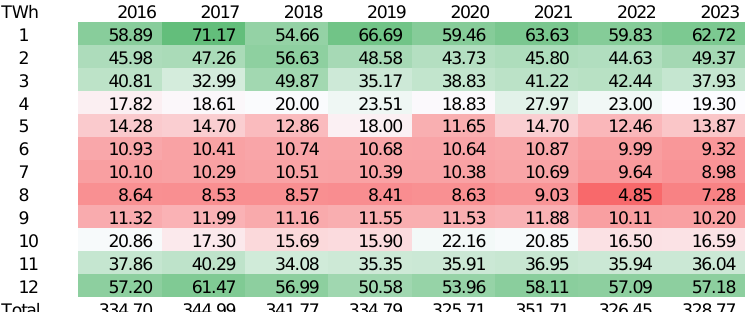
Figure 9. Neutral forecast of LNG for 2024. Forecast exercised for the period September 2022 to December 2023. These data can be found here: https://www. ec.europa.eu/ (accessed on 20 March 2022).